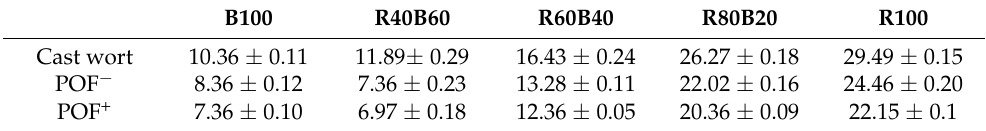
Table 2. EBC colour value of composite wort and beer after 4 weeks of maturation produced with BRY 97 ( S. cerevisiae ), POF − ; and Belle Saison ( S. cerevisiae var. diastaticus ), POF +